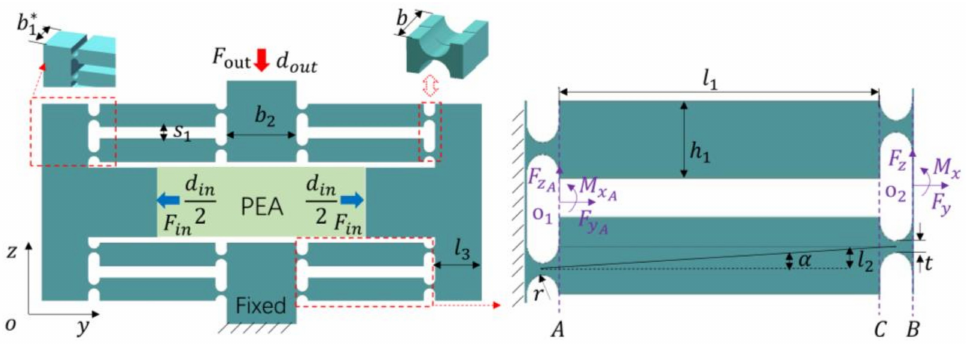
Figure 3. Composite bridge mechanism. Table 1. Flexibility matrix